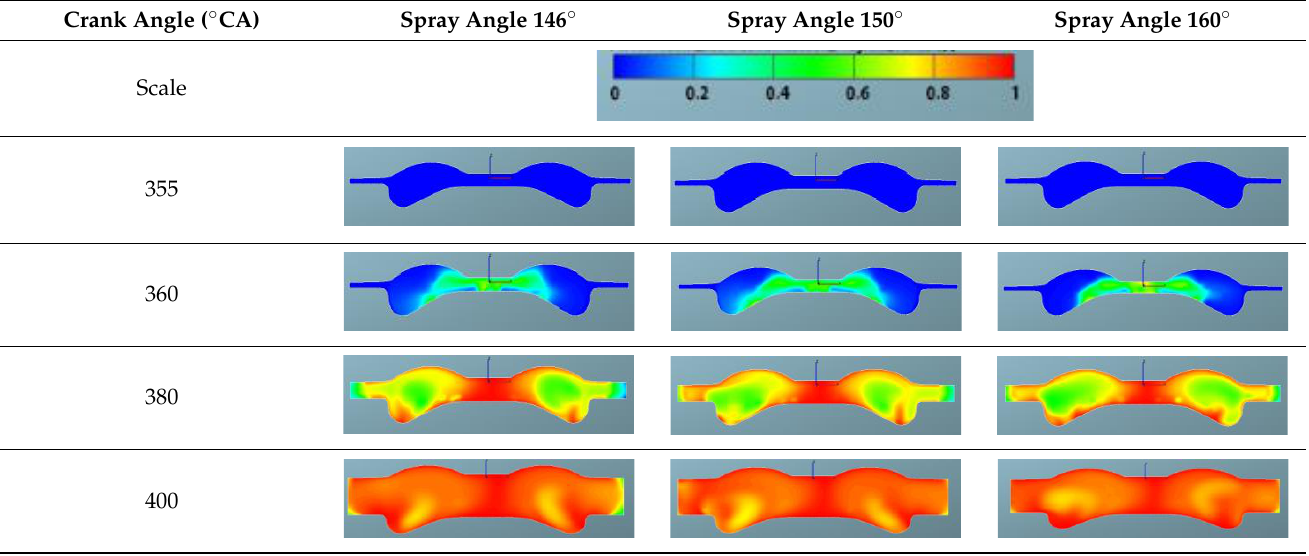
Table 12. Comparison of the combustion reaction rate of the F1 combustion chamber matched with different spray angles.